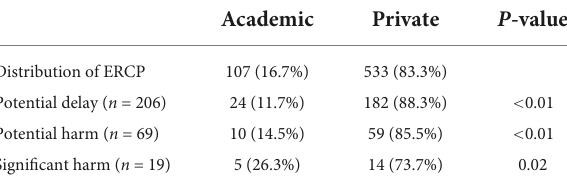
TABLE 2 Frequency of guidelines non-adherence causing delay in care, potential harm and significant harm comparing the academic vs. community